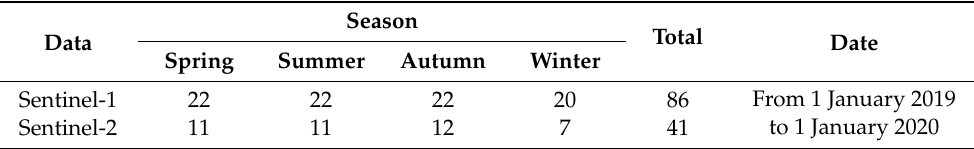
Table 2. The number of Sentinel-1 and Sentinel-2 satellite images in each season.